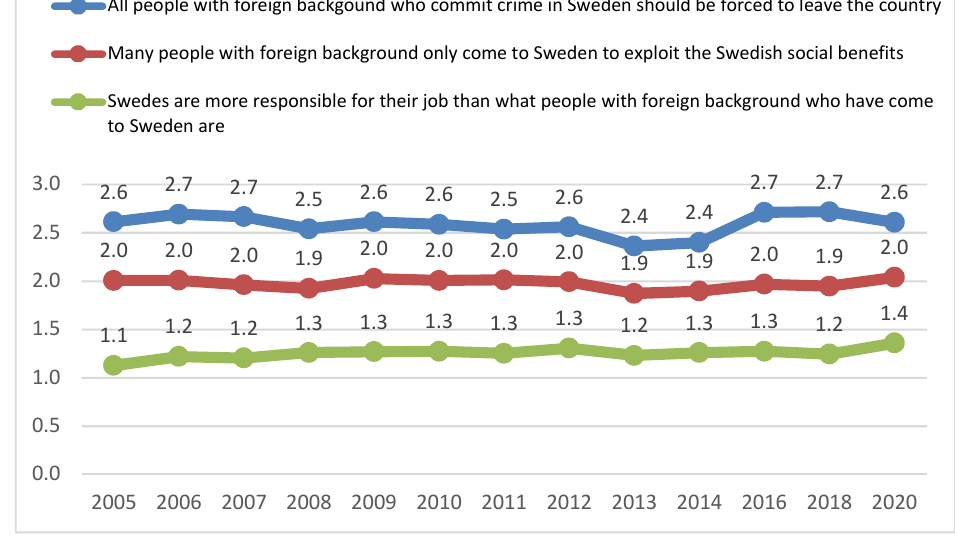
Figure 13. Three negative diversity indices (0–4) based on the three negative statements about diversity.